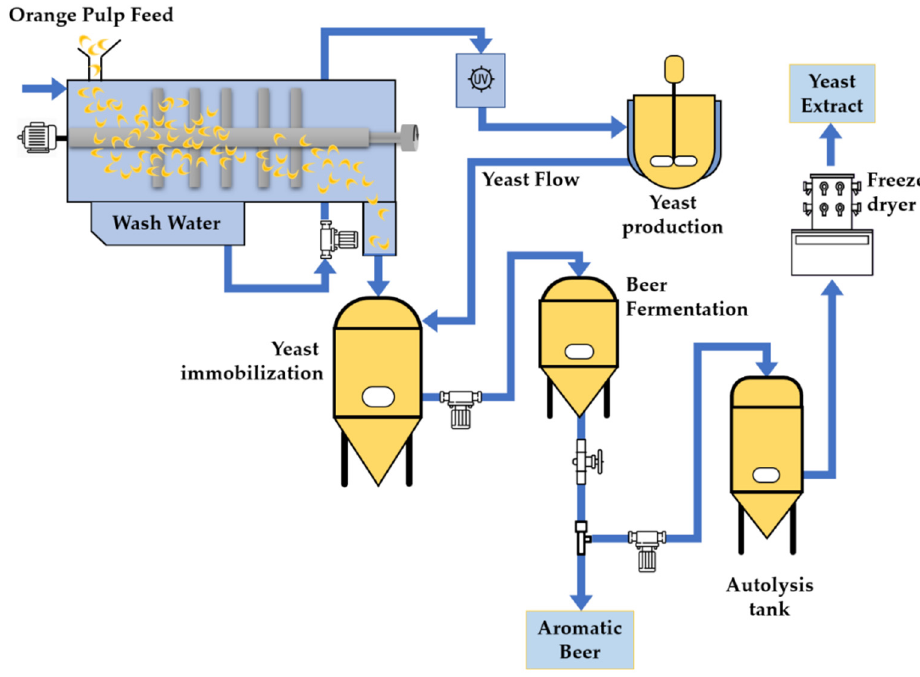
Figure 1. Refining concept for orange pulp valorization.